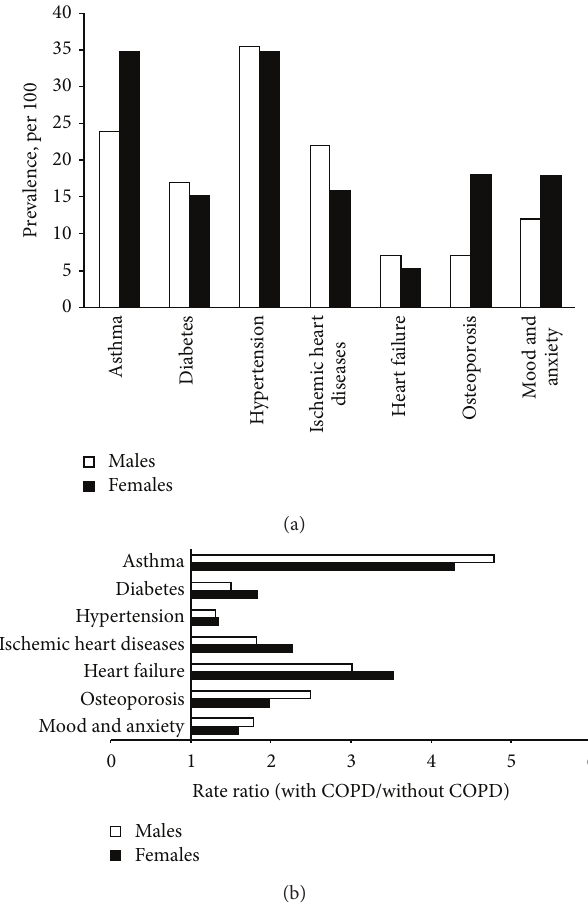
Figure 5: Comorbidities prevalence. (a) Age standardized comor- bidities prevalence among COPD, 35 years and older, by sexes for the period 2011. (b) Rate ratios of age standardized comorbidities rate among individuals with and without COPD 35 years and older, by sexes for the period